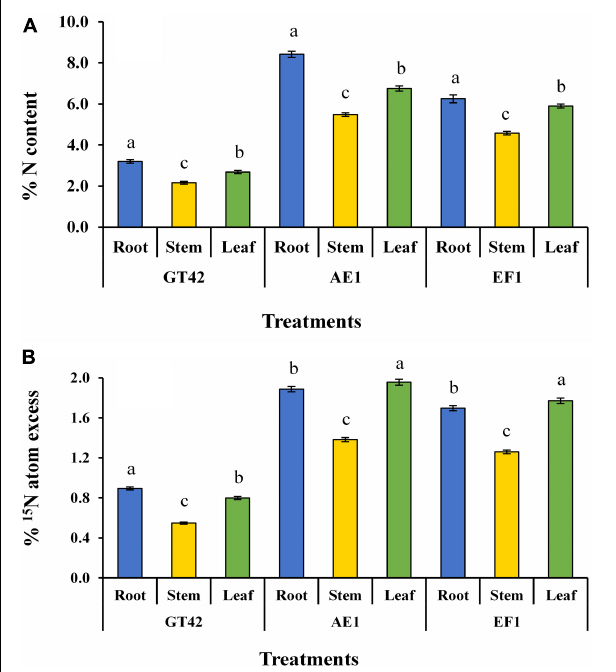
FIGURE 9 | Estimation of biological nitrogen fixation in sugarcane tissues (dry matter yield of root, stem, and leaf) by P. cypripedii AF1 and K. arachidis EF1 cultivated in 15 N-labeled soil (values are the average of three repeats) (A) % N content and (B) % 15 N atom excess. Significant changes among treatments at p ≤ 0.05 are showed by dissimilar